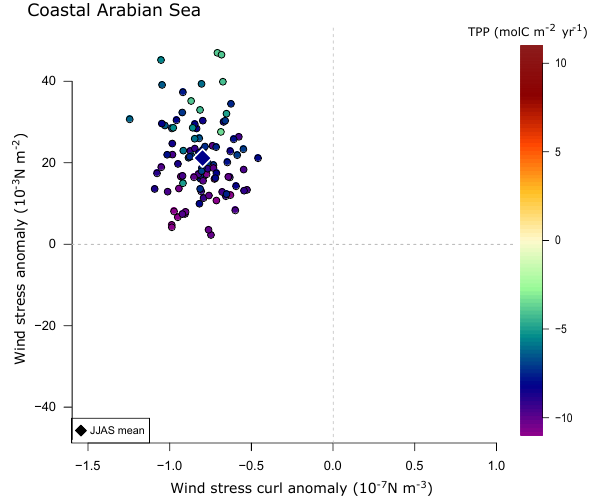
Figure 7. Seasonal (JJAS) anomalies of total primary productivity (TPP, molCm − 2 yr − 1 ), integrated over the whole water column, as a function of wind stress anomalies (10 − 3 Nm − 2 ) and wind stress curl anomalies (10 − 7 Nm − 3 ) in the coastal western Arabian Sea (see Fig. 2a). Anomalies are computed as the difference between each yearly summer average in the EH simulation and the seasonal summer mean of the CTRL simulation. The colour of the circles represents the value of the change in TPP between EH and CTRL. The colour scale, x axis range and y axis range are the same as those in Figs. 4 and 10.